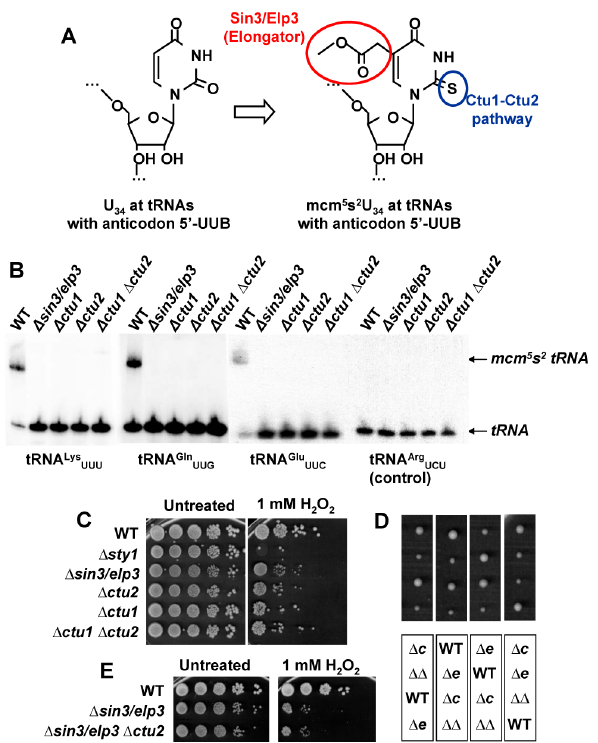
Figure 2. Sin3/Elp3 is required for modification of uridine-34 (U 34 ) at the anticodon of some cytoplasmic tRNAs. (A) Sin3/Elp3 and the Ctu1-Ctu2 pathways are required for the mcm 5 and s 2 modifications, respectively, at U 34 of some anticodons. (B) Northern blot analysis of bulk tRNA isolated from WT (972), IV16 ( D sin3/elp3 ), YDH 644 ( D ctu1 ), IV86 ( D ctu2 ), and YDH 254 ( D ctu1 D ctu2 ) using specific probes against tRNA Lys UUU , tRNA Gln UUG , tRNA Glu UUC and tRNA Arg UCU (negative control) by the APM-gel retardation method. The position of the unmodified ( tRNA ) or modified ( mcm 5 s 2 tRNA ) tRNAs are indicated with arrows. (C) D ctu1 and D ctu2 strains are sensitive to oxidative stress. Serial dilutions from cultures of strains 972 (WT), AV18 ( D sty1 ), IV16 ( D sin3/elp3 ), IV86 ( D ctu2 ), YDH 644 ( D ctu1 ), YDH 254 ( D ctu1 D ctu2 ) were spotted onto rich plates without (Untreated) or with 1 mM H 2 O 2 . (D) Double mutant D sin3 / elp3 D ctu2 colonies are similar in size to single mutant D sin3 / elp3 . Tetrad analysis of a cross between IV16 ( D sin3/elp3 ) and IV86 ( D ctu2 ) strains. Each vertical box corresponds to the four spores of a tetrad. The genotypes of each colony of the top panel are indicated in the corresponding positions of the bottom panel: WT, D ctu2 ( D c), D sin3/elp3 ( D e) or D sin3/elp3 D ctu2 ( DD ) . (E) Single mutant D sin3 / elp3 and double mutant D sin3 / elp3 D ctu2 show similar sensitivity to oxidative stress. Serial dilutions from cultures of strains 972 (WT), IV16 ( D sin3/elp3 ) and JF73 ( D sin3/elp3 D ctu2 ) were spotted onto rich plates without (Untreated) or with 1 mM H 2 O 2 .